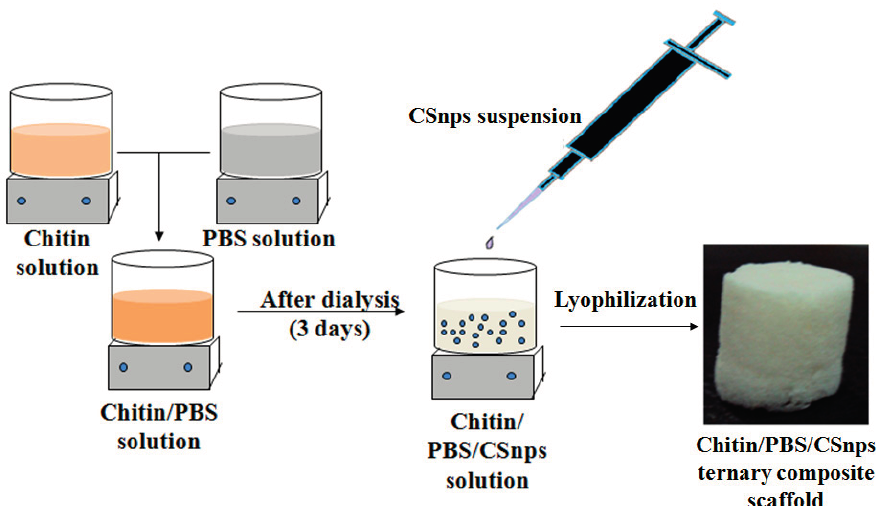
Figure 1. Schematic representation of scaffold